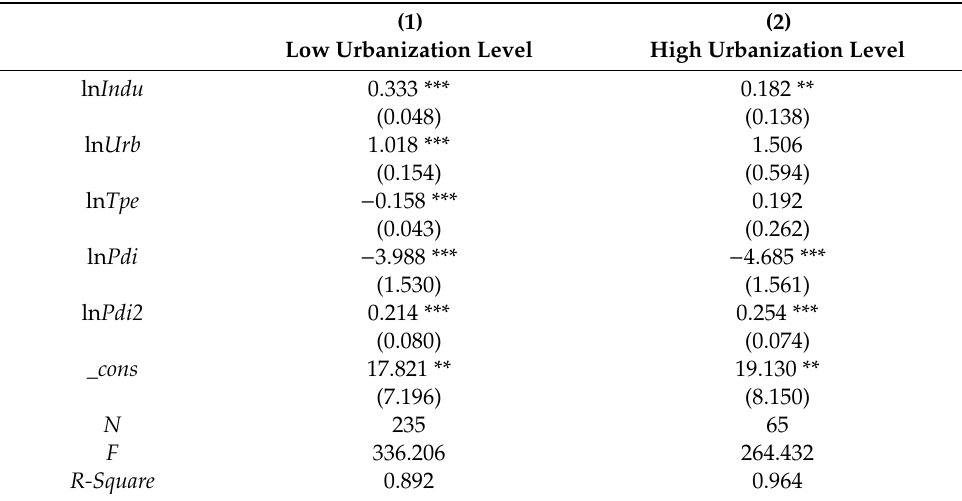
Table 5. Estimation results of samples based on urbanization